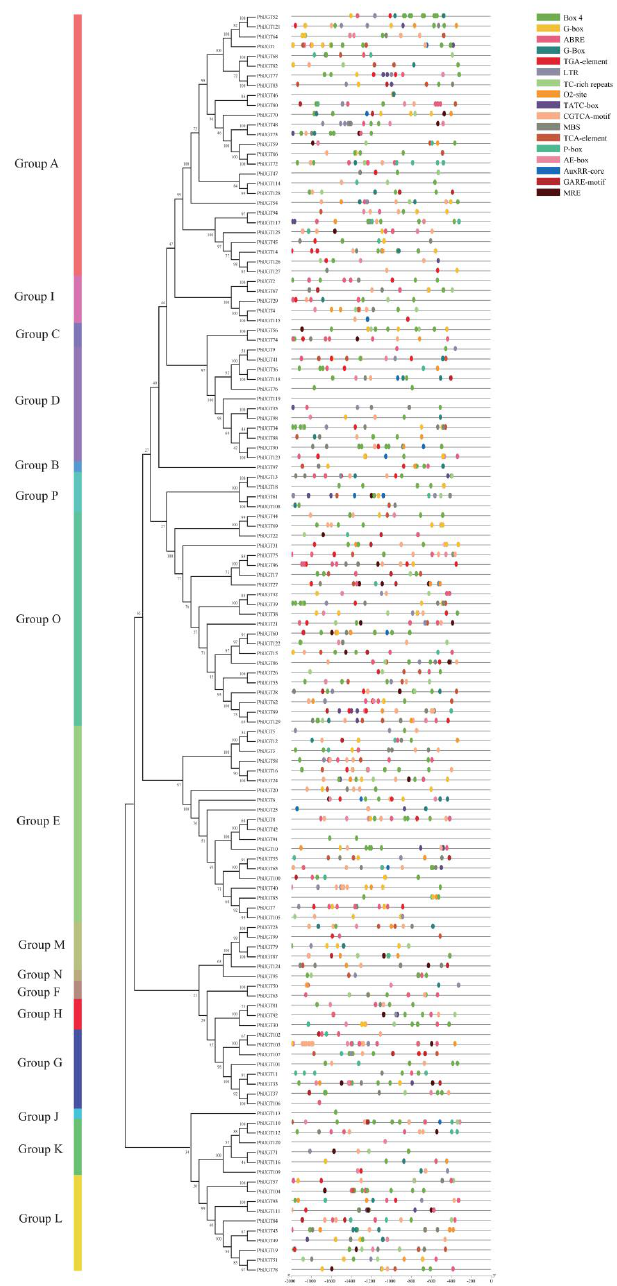
Figure 3. Predicted cis-acting elements in the promoter regions of PhUGT genes.